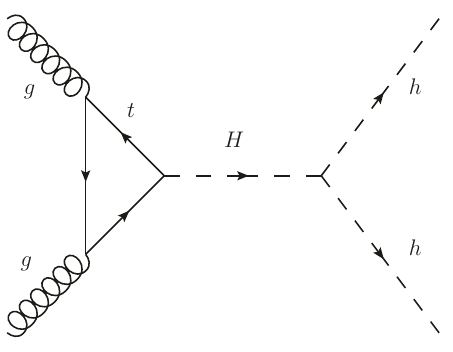
Figure 1 . Feynman diagram for the signal production from pp decay to the corresponding (cid:12)nal states viz. h